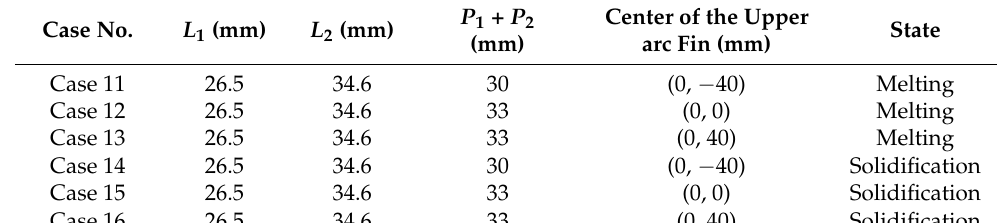
Figure 17. Schematic of arc-shaped fins.